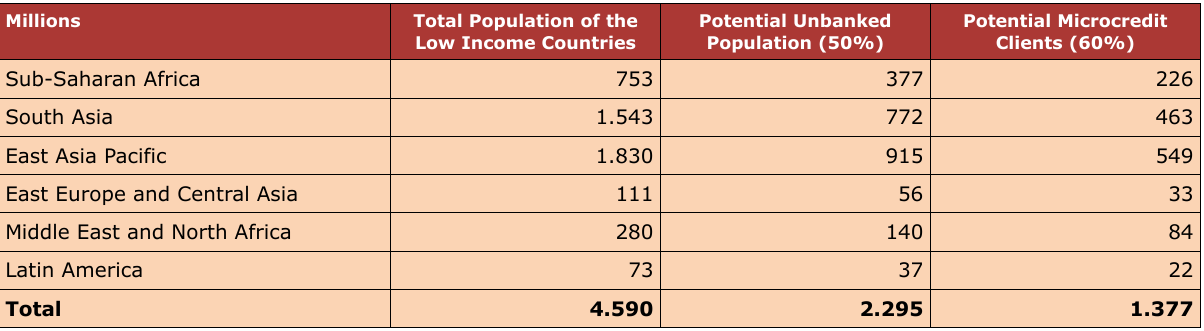
Figure 1. Potential MFI Clients (CGAP,